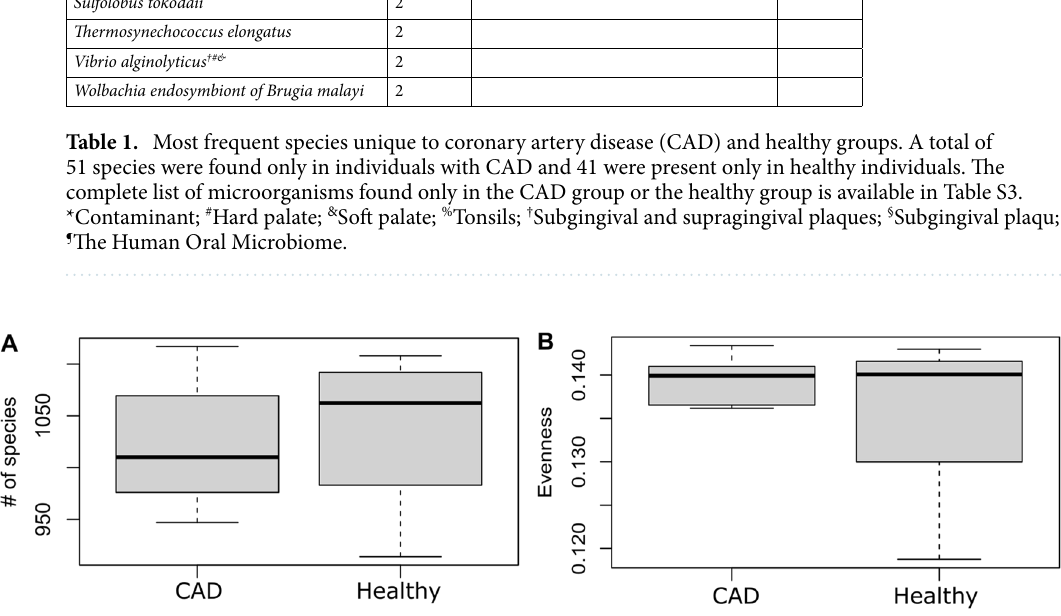
Figure 3. ( A ) Box plot of the mean number of species in the CAD and healthy groups. ( B ) Comparison of Simpson evenness between the CAD and healthy groups.